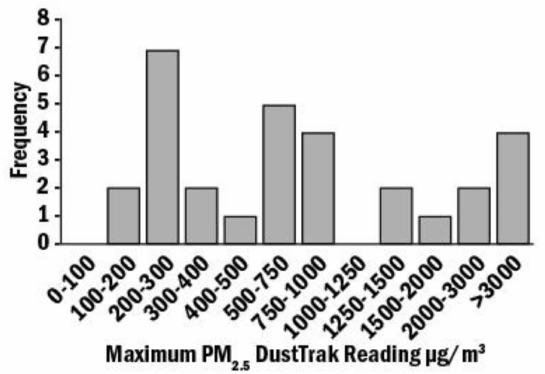
Figure 2. PM 2.5 concentration in DustTrack from 30 homes. A DustTrak Aerosol Monitor was used to monitor real time aerosol. Mean PM 2.5 ranged from 100–200 µ g/m 3 to >3000 µ g/m 3 in the 30 homes.